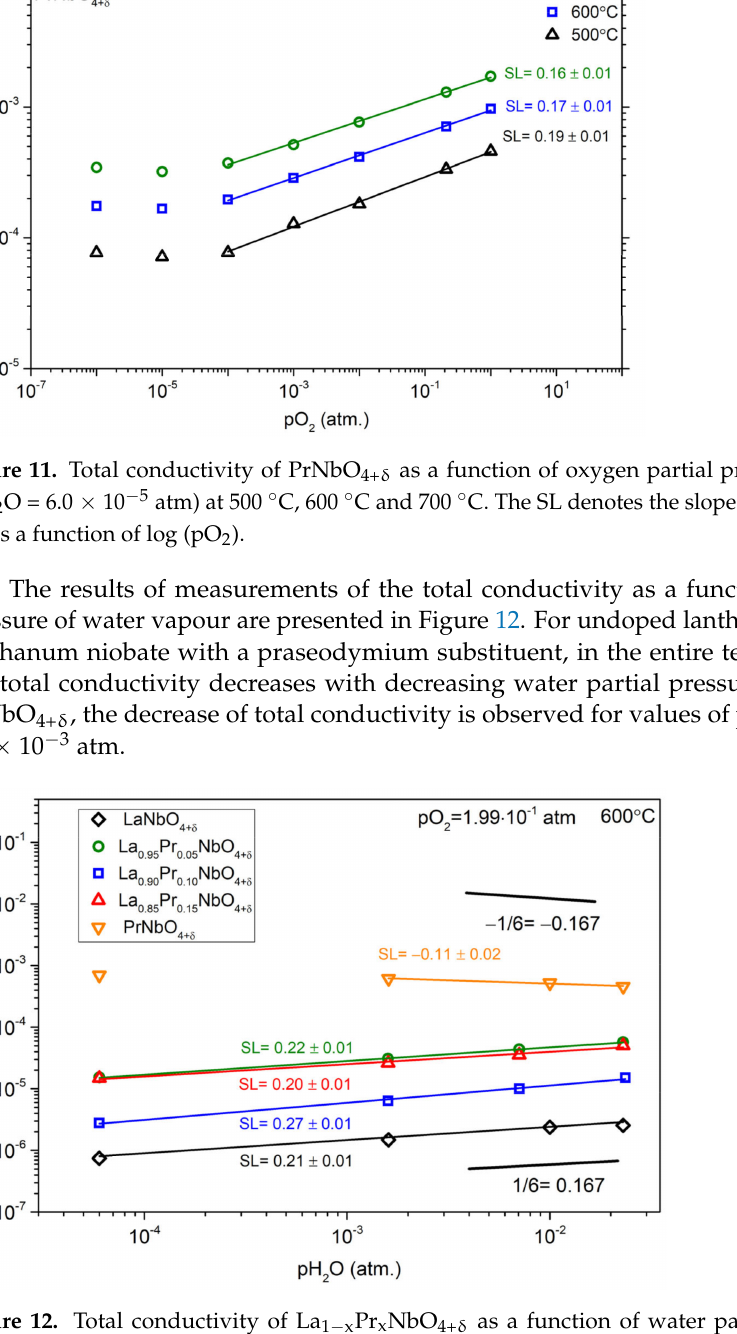
Figure 12. Total conductivity of La 1 − x Pr x NbO 4+ δ as a function of water partial pressure in air (pO 2 = 0.2 atm) at 600 ◦ C. The SL denotes the slope coefficient of the line describing the log ( σ ) in a function of log (pH 2